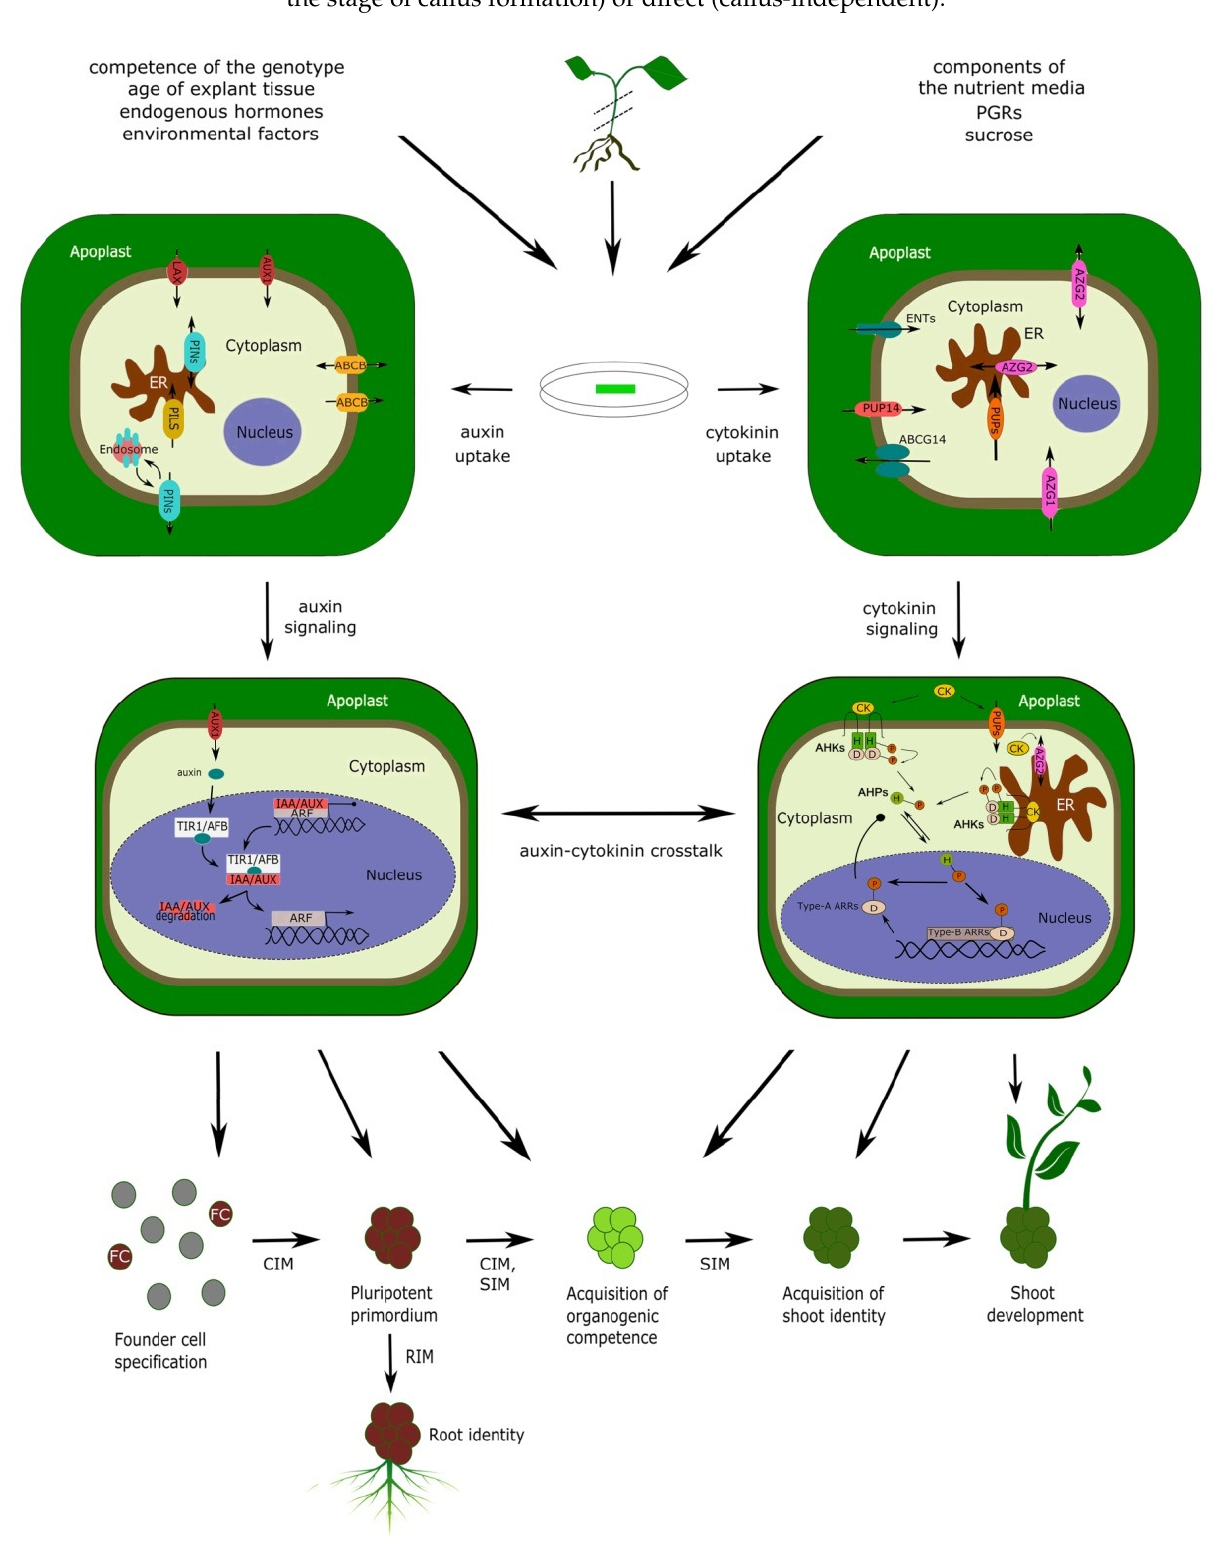
Figure 1. An integrative model for the roles of auxin and cytokinin (CK) in de novo shoot organogenesis (DNSO) in Arabidopsis thaliana . Shoot regeneration is affected by explant characteristics, such as the competence of the genotype, age of the explant tissue and its endogenous hormones, as well as by environmental conditions. Components of the regeneration media, such as exogenously added plant growth regulators (PGRs) or a carbon source (e.g., sucrose), affect regeneration efficiency. The plant hormones auxin (left side of the diagram) and CK (right side) are taken up from the regeneration medium and transported through plant tissues and into the cells. Auxin transport (upper left cell) relies, among other molecules, on auxin influx carriers AUXIN-RESISTANT1 (AUX1) and LIKE-AUX1 (LAX), efflux carriers PIN-FORMED (PIN) and transporters of the ATP-BINDING CASSETTE-B (ABCB) family. The PIN efflux carriers have a polar distribu- tion on the plasma membrane and undergo endocytic recycling, but they are also present at the ER membrane, together with the PILS transporters. CK transport (upper right cell) relies on PURINE PERMEASEs (PUPs), EQUILIBRATIVE NU- CLEOSIDE TRANSPORTERs (ENTs), ATP-BINDING CASSETTE-G (ABCG) and AZA-GUANINE RESISTANT (AZG) transporters. Once they reach their target cells, plant hormones bind to their respective receptors, triggering the corre- sponding signaling cascades. Auxin signalization (bottom left cell) begins when the auxin binds to the nuclear receptor TRANSPORT INHIBITOR RESPONSE1/AUXIN SIGNALING F-BOX (TIR1/AFB). The auxin-TIR1/AFB complex then re- leases the transcription factors of the AUXIN RESPONSE FACTOR (ARF) family from the repressive interaction with the